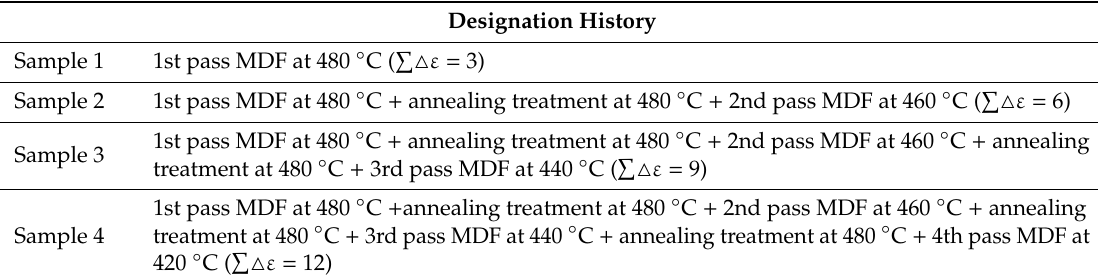
Table 2. Designation and history of the studied